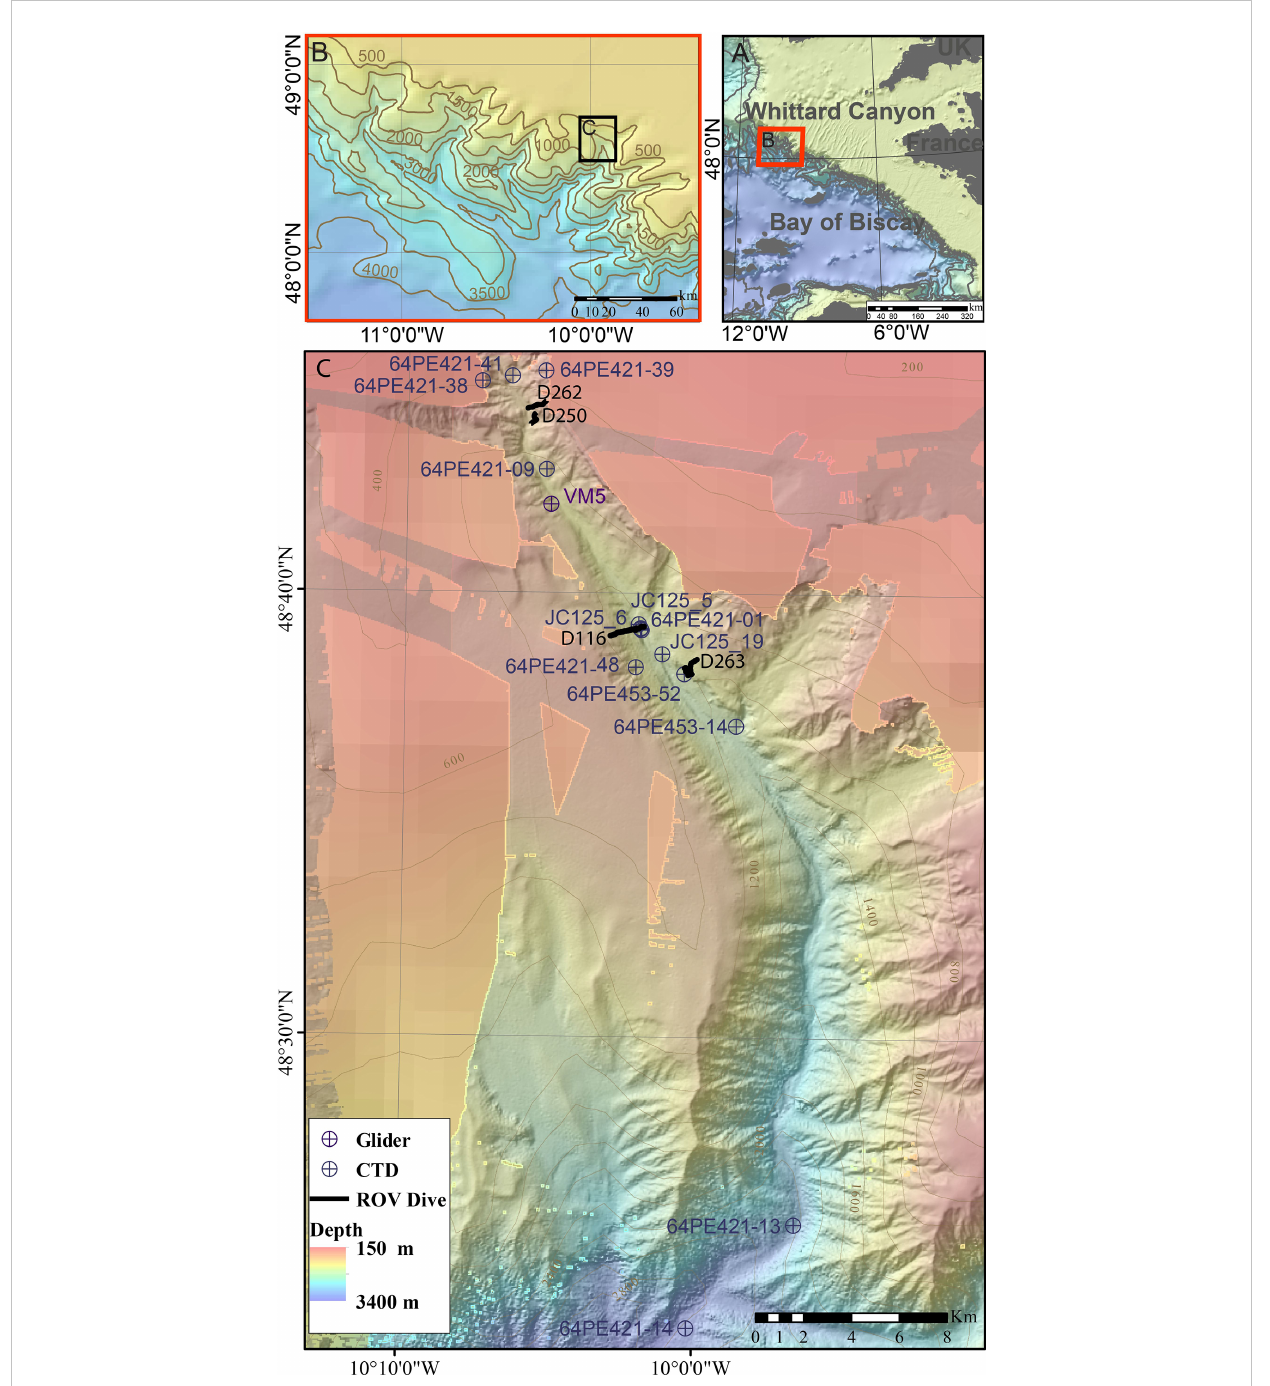
FIGURE 1 Location map of (A) Whittard Canyon and (B) the Eastern branch of Whittard Canyon (C) data acquired from the Eastern branch during the J036, JC125, 64PE421 and 64PE435 cruises. Background bathymetry from JC125 and GEBCO compilation group